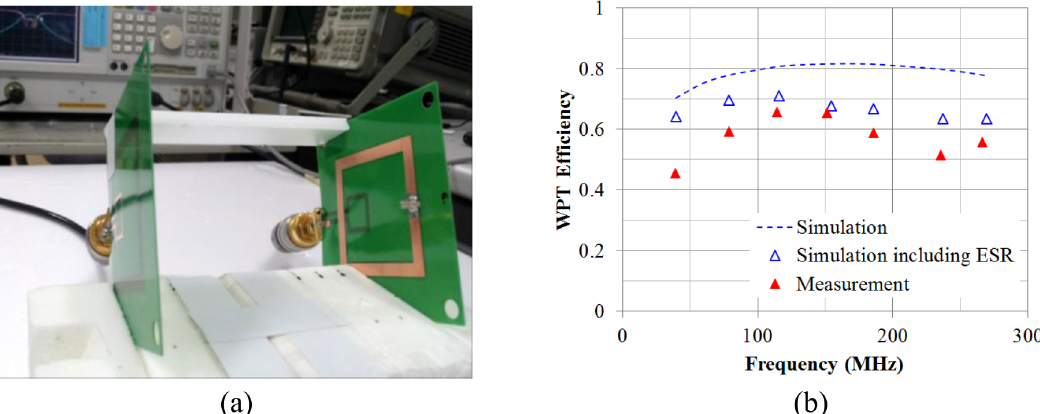
Fig. 11. (a) Photograph of the measurement setup and (b) simulated and measured WPT ef fi ciency of two identical MZRs.